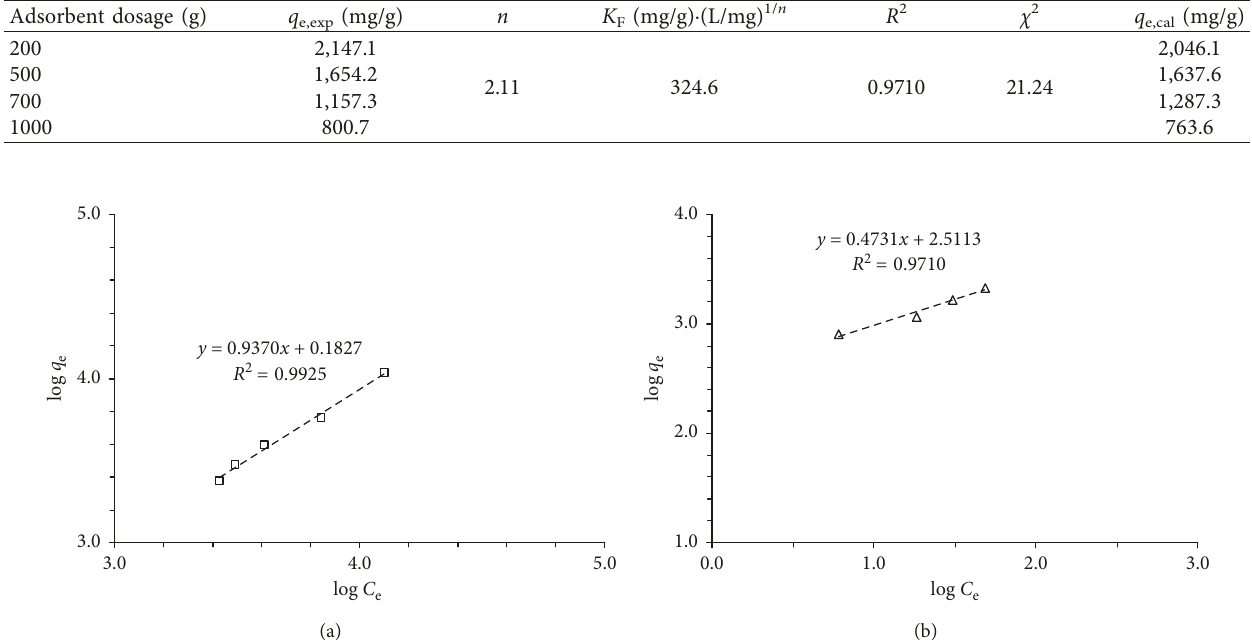
Table 4: Freundlich isotherm constants using modified bagasse using a pilot-scale system. Adsorbent dosage (g)